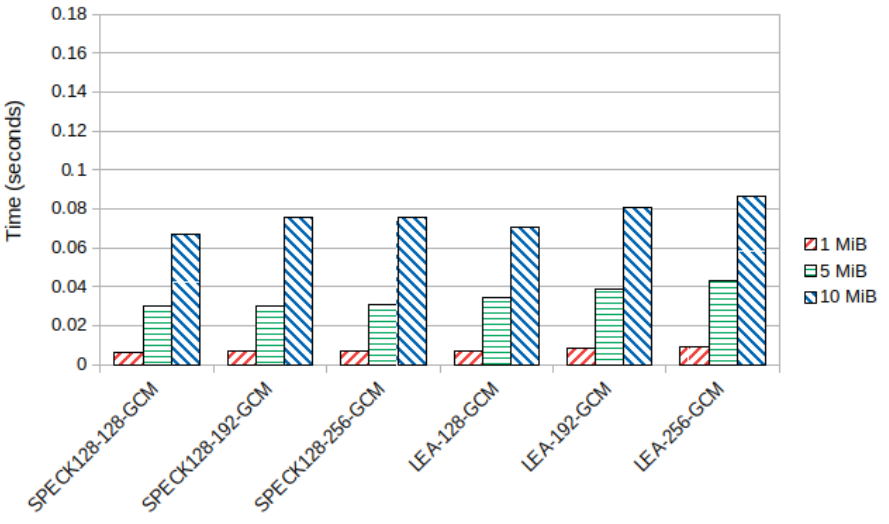
Figure 7. Average lightweight block cipher encryption time (seconds) in the ARMv8-a Xiaomi